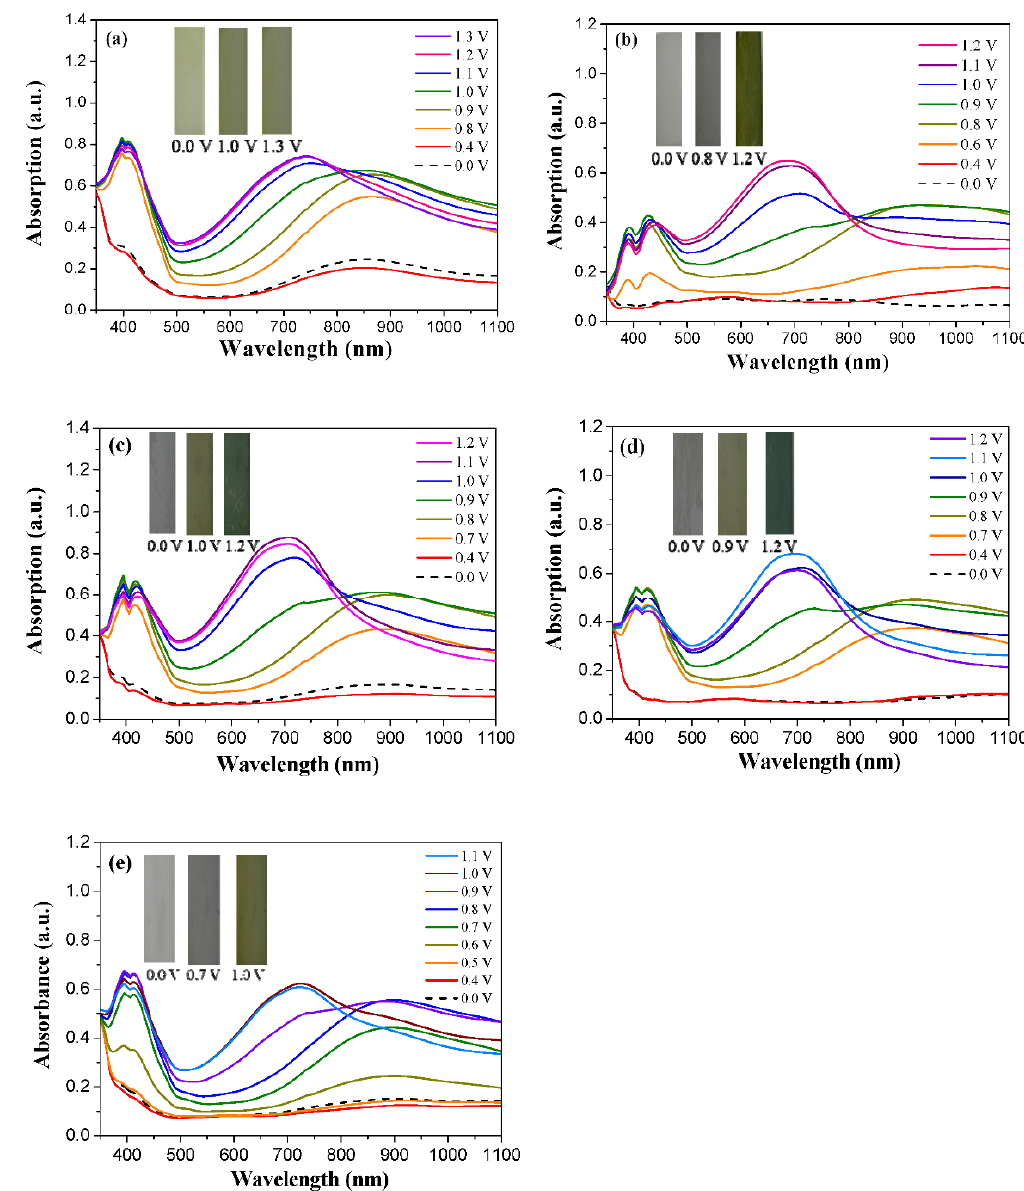
Figure 5. UV–Vis spectra of ( a ) P(DCB), ( b ) P(DCB- co -ED), ( c ) P(2DCB- co -ED), ( d ) P(DCB- co -EDm), and ( e ) P(2DCB- co -EDm).